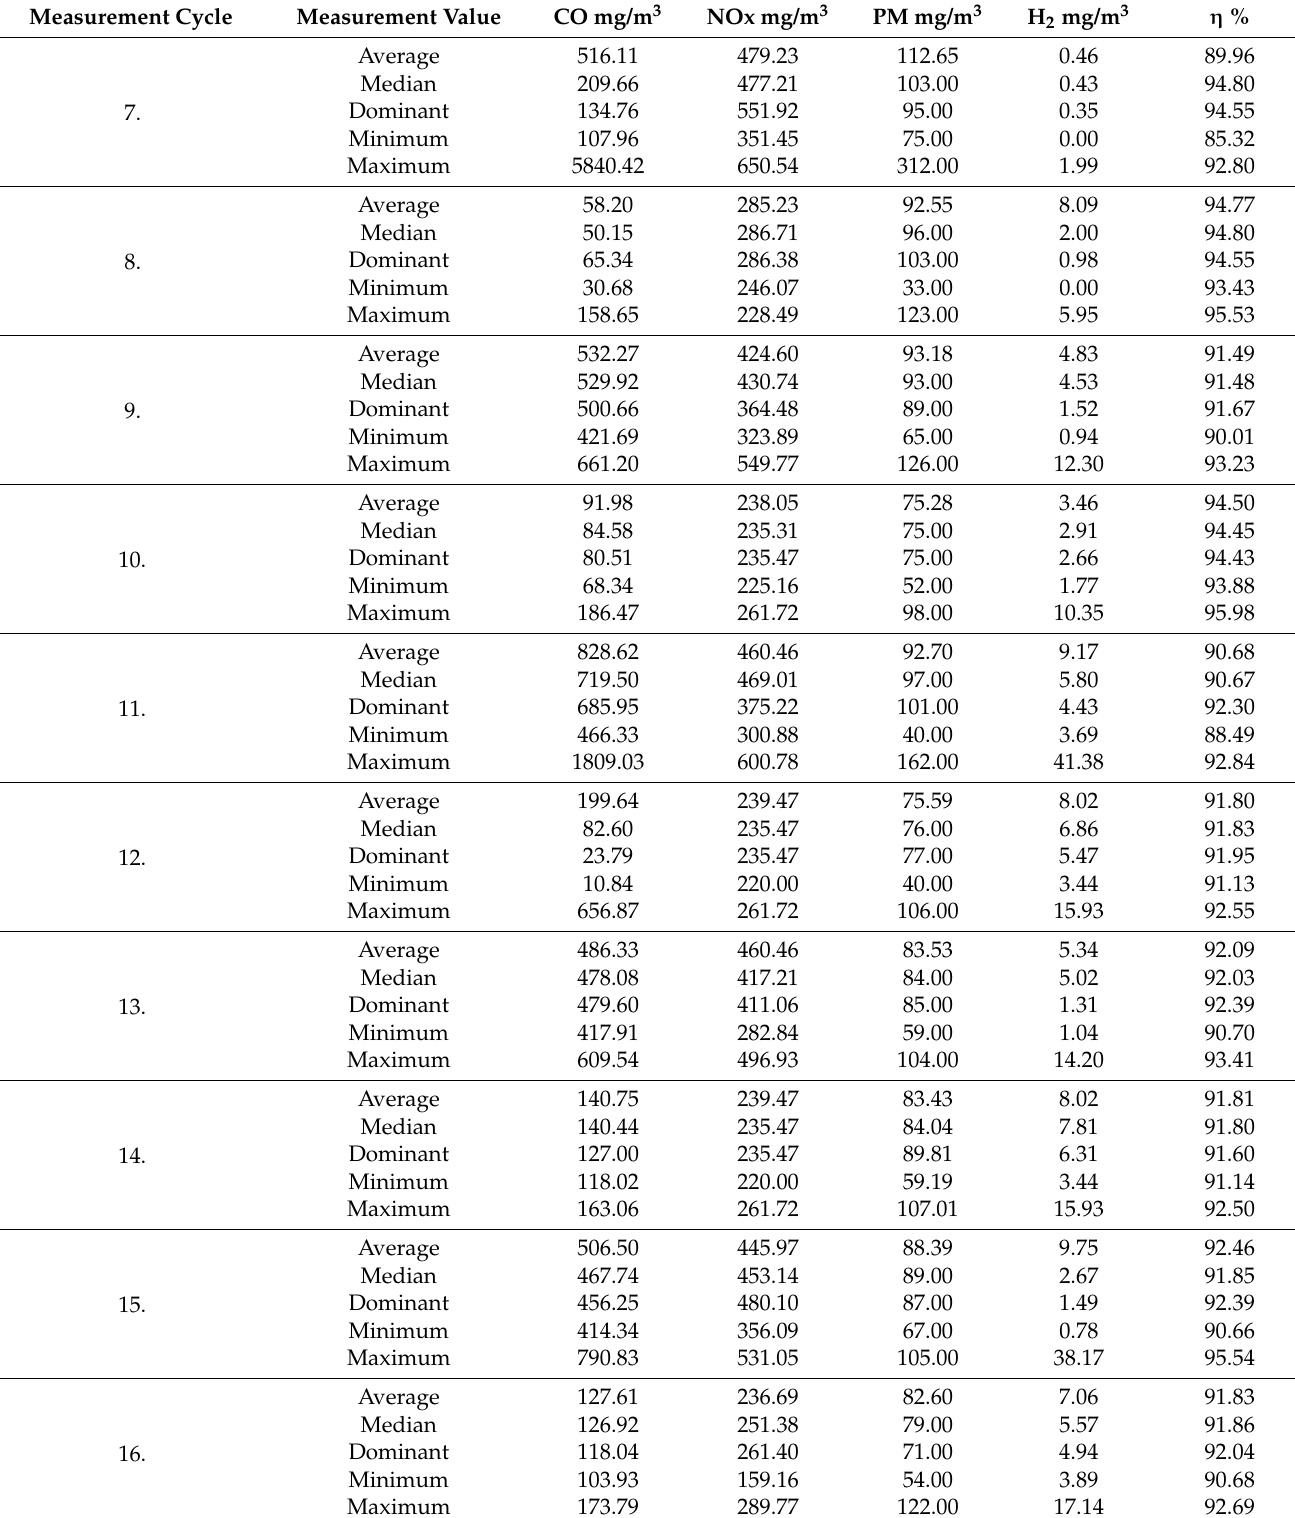
Table 5. Results of the second stage of